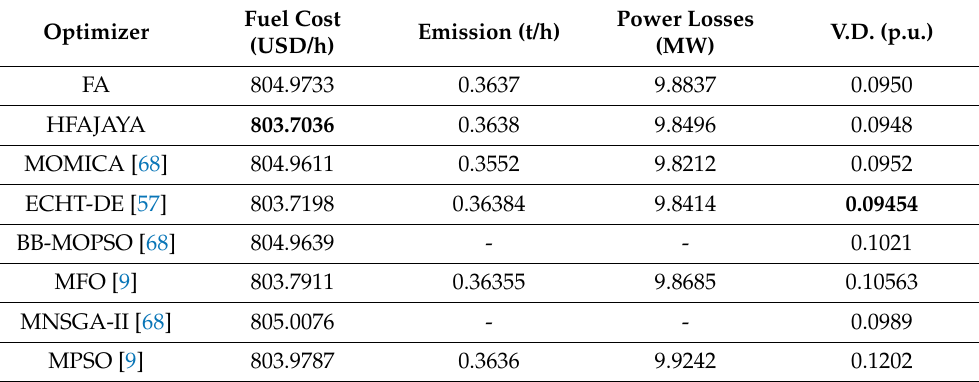
Table 7. The obtained optimal results in the current works for Case